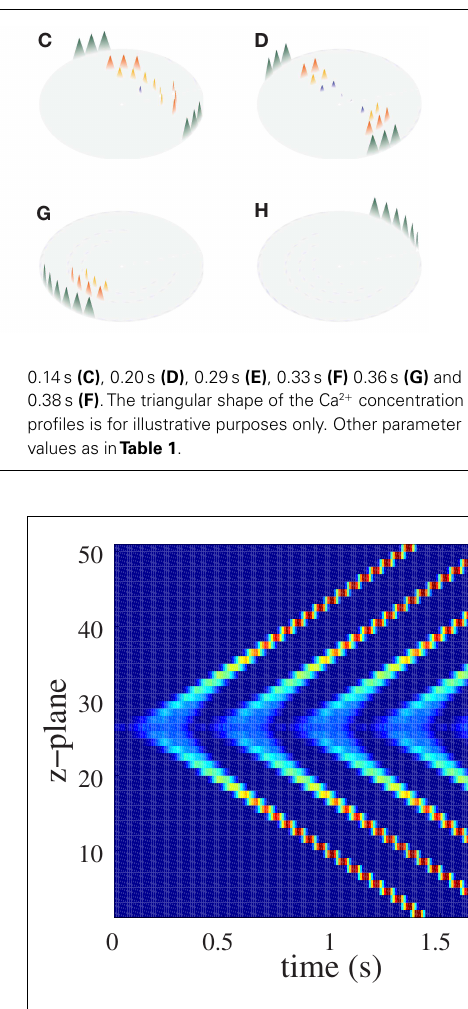
FIGURE 4 | Ping wave and longitudinal Ca 2 + waves for the parameter values in Figure 3. The ping wave is triggered by initially elevating the Ca 2 + concentration above threshold at the six release sites colored black in Figure 1 in the central z-plane.Warm colors indicate substantial Ca 2 + release site activity, while cool colors correspond to lesser Ca 2 + release